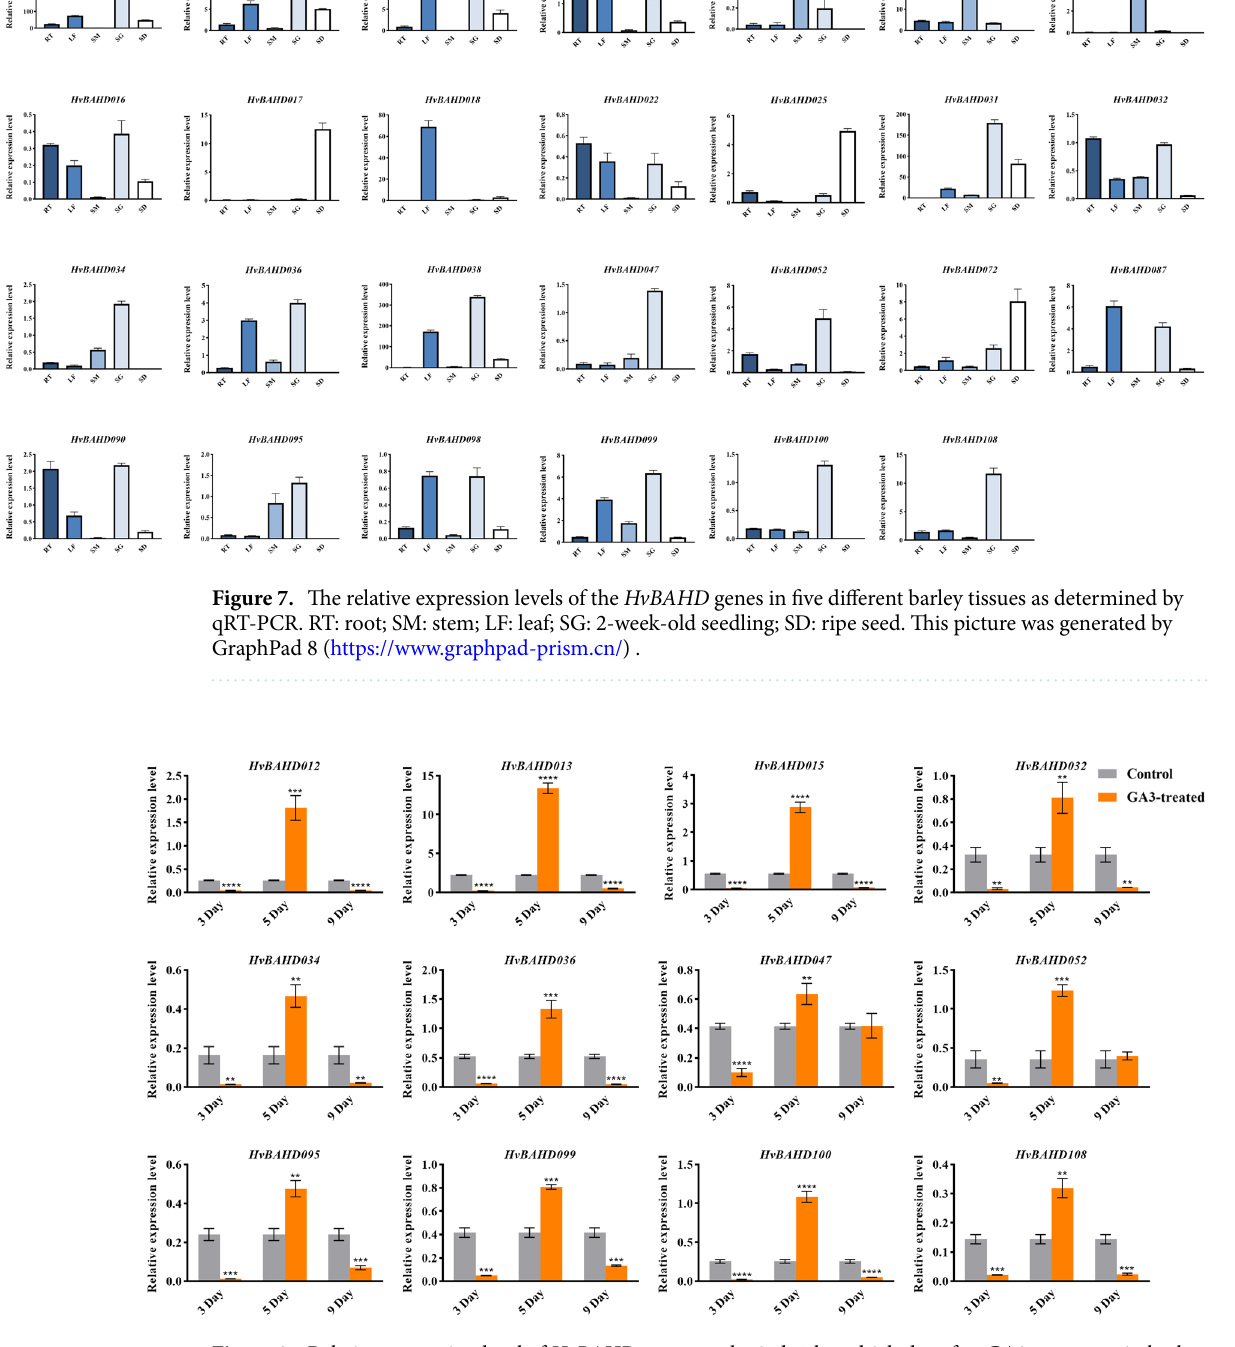
Figure 8. Relative expression level of HvBAHD genes on the 3rd, 5th and 9th day after GA3 treatment in barley leaves. Gray shows the control group and orange indicates the GA3 treatment group. (P < 0.0001, ****, P < 0.001, ***, P < 0.01, **, P < 0.1, *). This picture was generated by GraphPad 8 (https:// www. graph pad- prism. cn/)